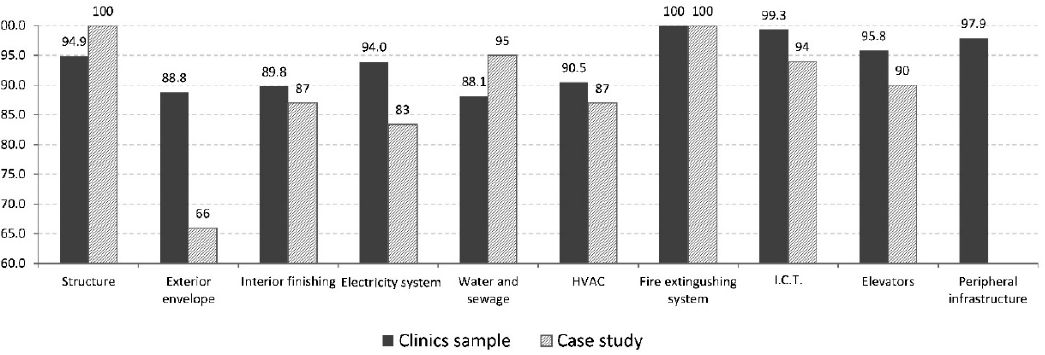
Fig. 7. Comparison of the building system performance: the clinic sample versus the case study